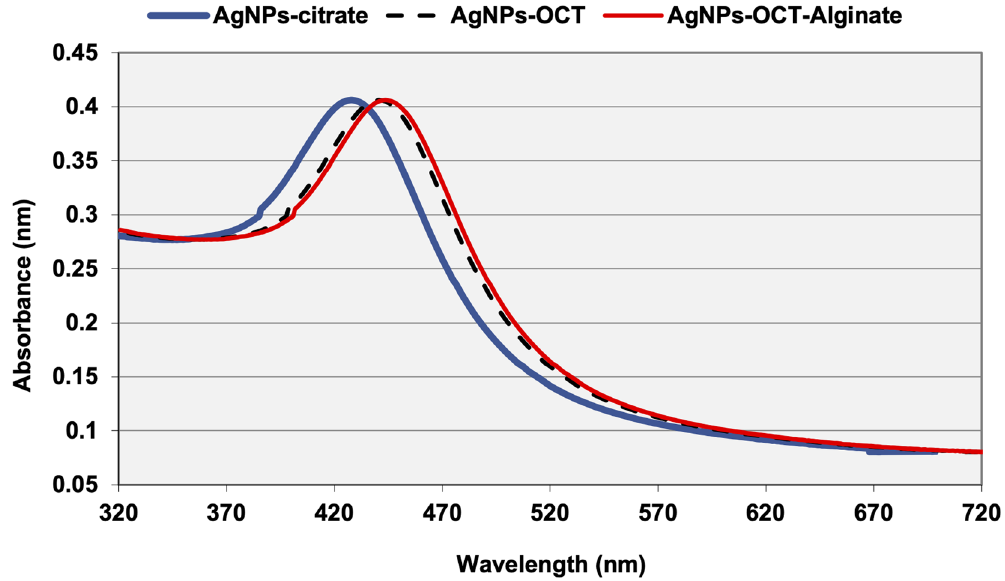
Figure 3: UV - Vis spectra of AgNPs – CTT, AgNPs – OCT and AgNPs – OCT – Alg. The AgNPs – OCT and AgNPs – OCT – Alg showed redshifts in their SPR